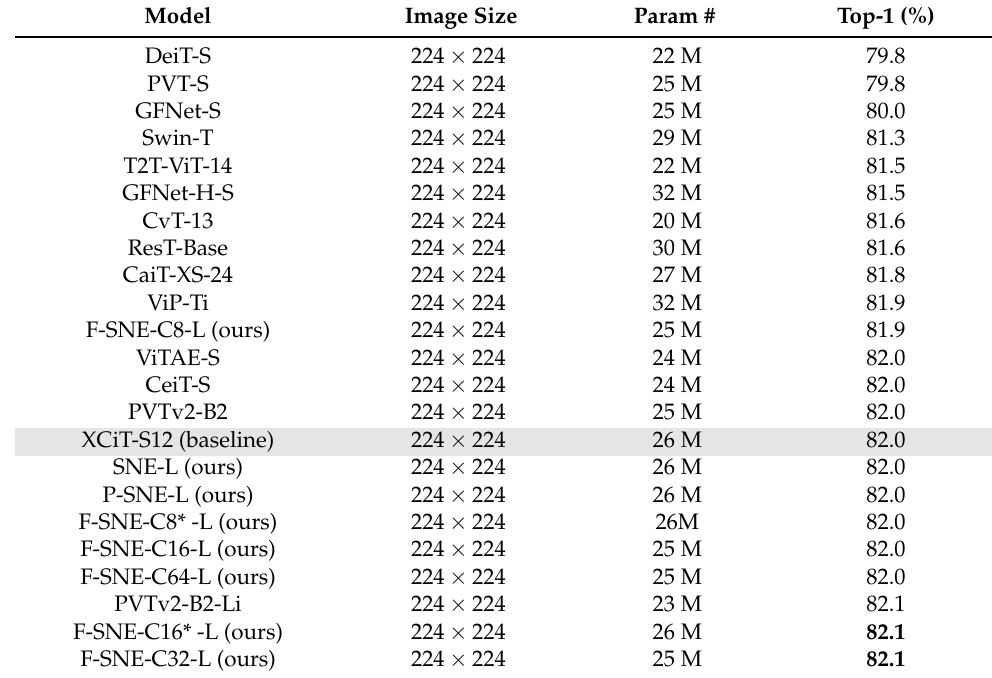
Table 4. Proposed large (L) models were evaluated on ImageNet classification task.